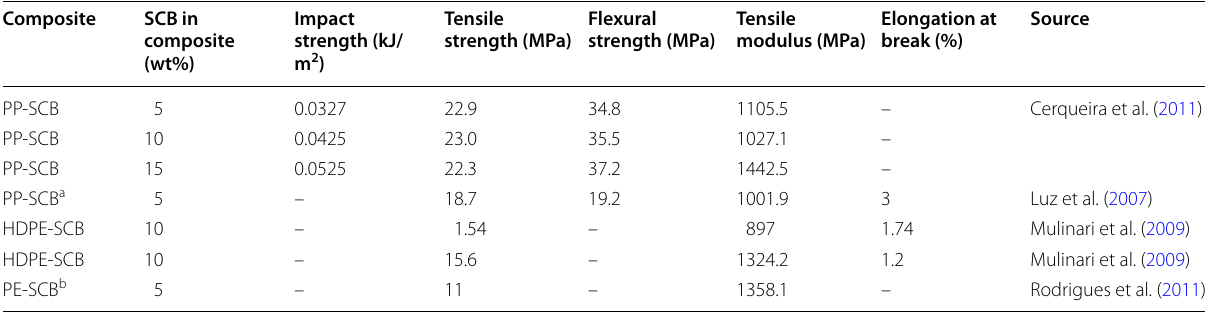
PP polypropylene, HDPE high-density polyethene, P phenolic thermoset, PE polyester a Obtained by compression moulding, b unmodified fibres